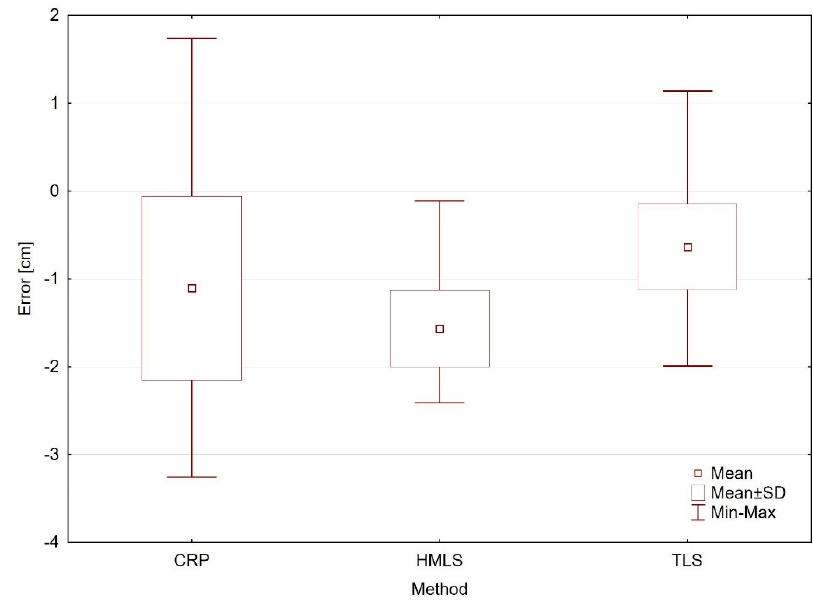
Figure 4. DBH estimation errors.